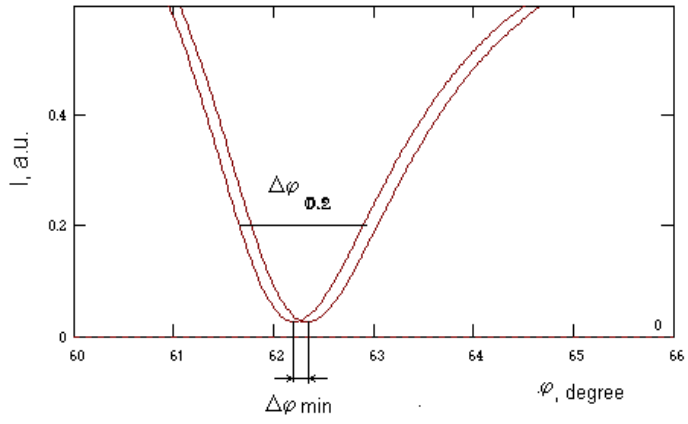
Figure 1. Parameters of SPR curve: the shift of the minimum ( ∆ϕ at the light intensity corresponding 0.2 of the maximal one ( ∆ϕ